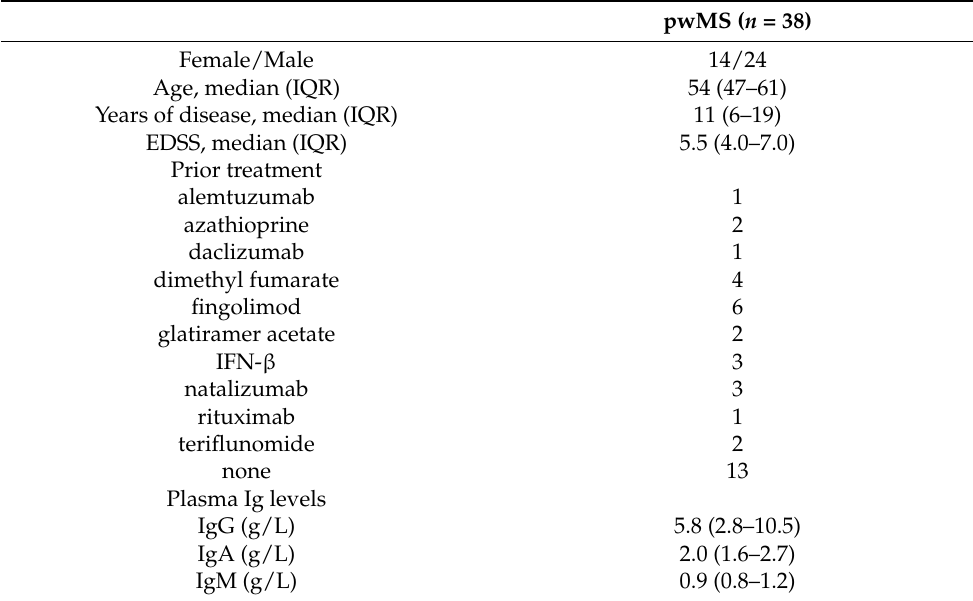
Table 1. Clinical and demographic features of enrolled